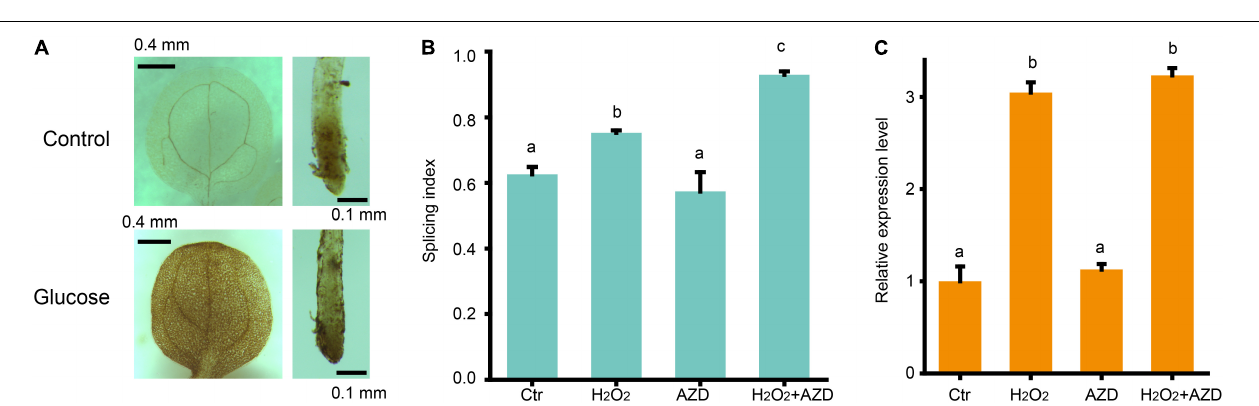
FIGURE 4 | Glucose stress regulates AS pattern change of GRP7 via TOR pathway. (A) Venn diagram showing an overlap between DEGs upon 3% glucose and DEGs regulated by TOR kinase in glucose signaling. hi_Glc_up: DEGs upregulated by 3% glucose; hi_Glc_down: DEGs down-regulated by 3% glucose; TOR_target_up: DEGs upregulated by TOR; TOR_target_down: DEGs down-regulated by TOR. (B) The SI of GRP7 transcripts upon different treatments. (C) The expression levels of GRP7 upon different treatments. Ctr, 0% glucose; Glc, 3% glucose; AZD, 0% glucose + 2 µ M AZD-8055; Glc + AZD, 3% glucose + 2 µ M AZD-8055.